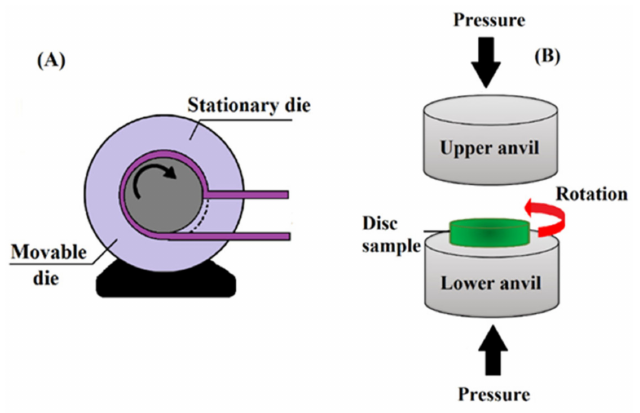
Figure 3. Principle of the ECAP–conformation technique ( A ); reproduced from [45]; Schematic illustration of the high-pressure torsion (HPT) process ( B ); reproduced from